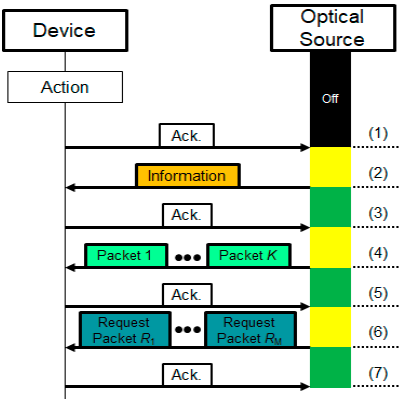
Figure 7. Streaming data transmission using the ARQ approach.